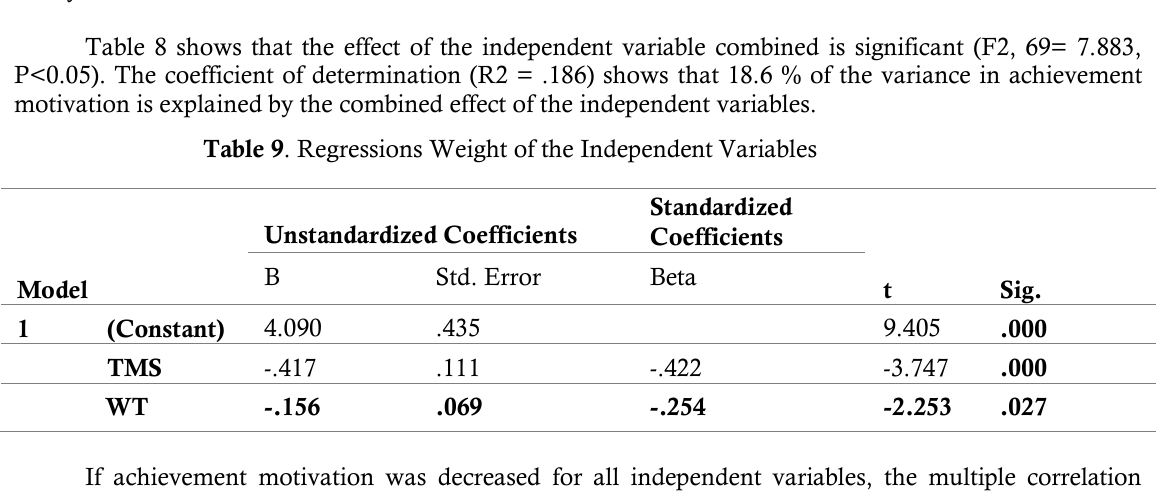
Table 8 . Results of Regression of Heavy TV Viewers’ Achievement Motivation on the Independent Variables Df sum of mean F sig. squares square Regression 2 2.157 1.078 7.883 .001 b Residual 69 9.440 .137 Multiple R= .431a R square= .186 Adjusted R square=.162